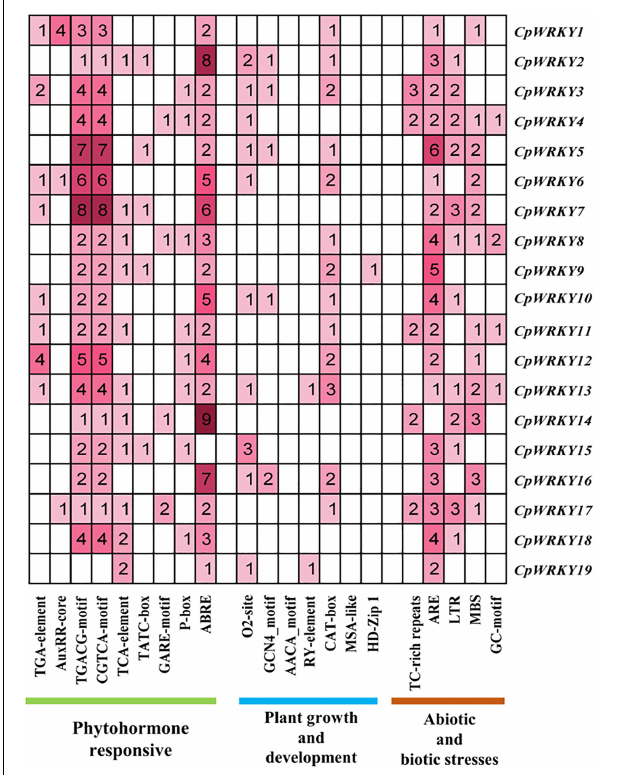
FIGURE 4 | Cis -acting elements analysis in promoter regions of 19 CpWRKY genes.